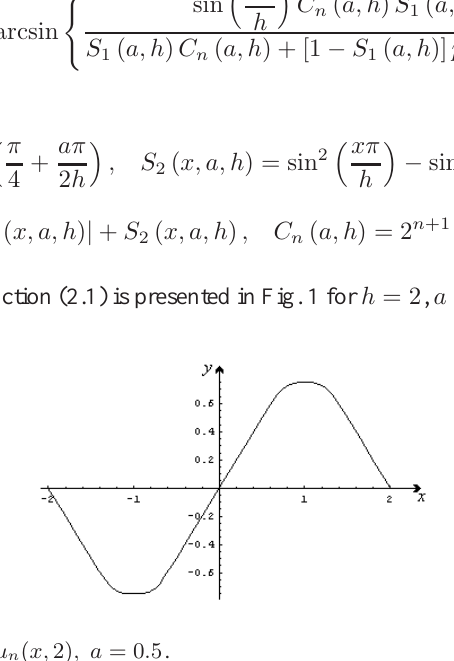
Figure 1. Function µ n ( x, 2) , a = 0 . 5